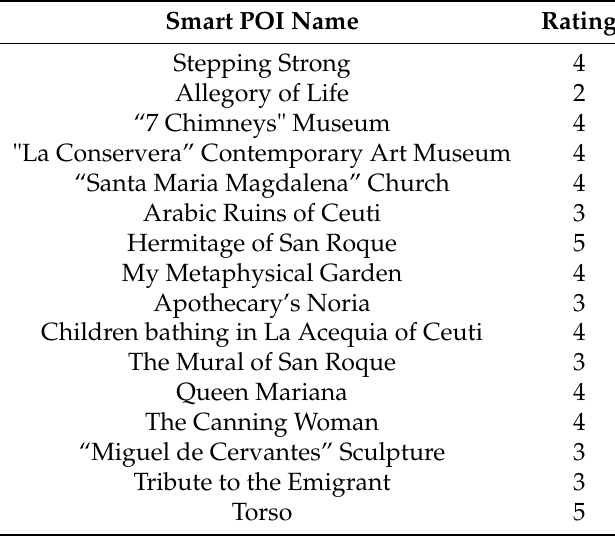
Table 3. User preferences identified by User-CEUTI-1.